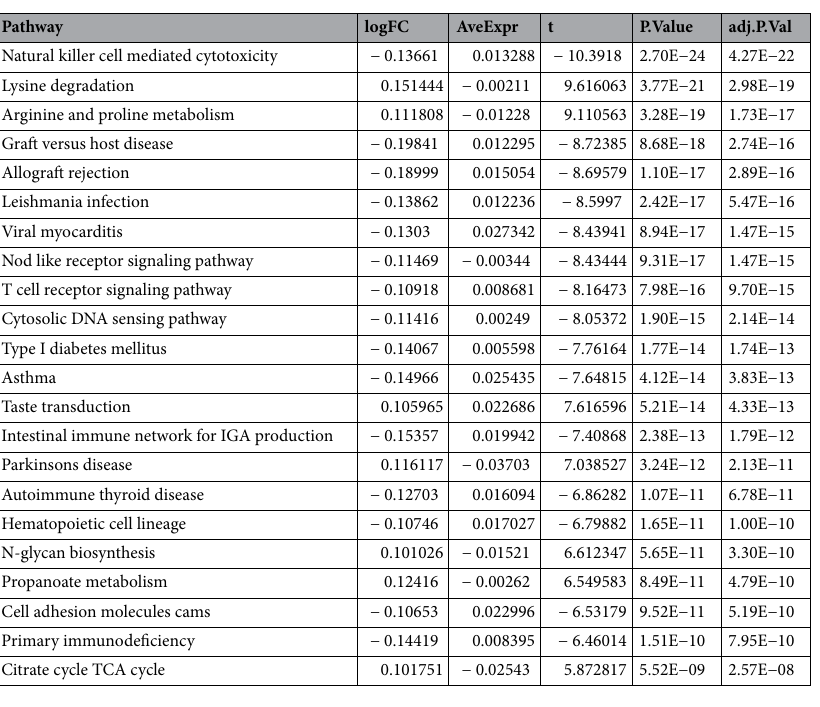
Table 4. The activation states of biological pathways in distinct m 6 A modification patterns by GSVA enrichment analysis (A vs. C). AveExpr: average expression, adj. p val: adjust p